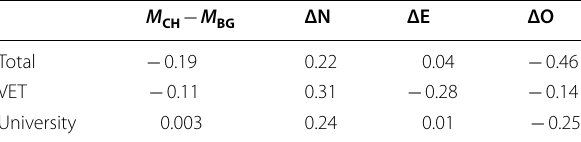
Table 5 Decomposition of the country-differences Table 6 Influence of educational gender concentration and linkage strength on occupational